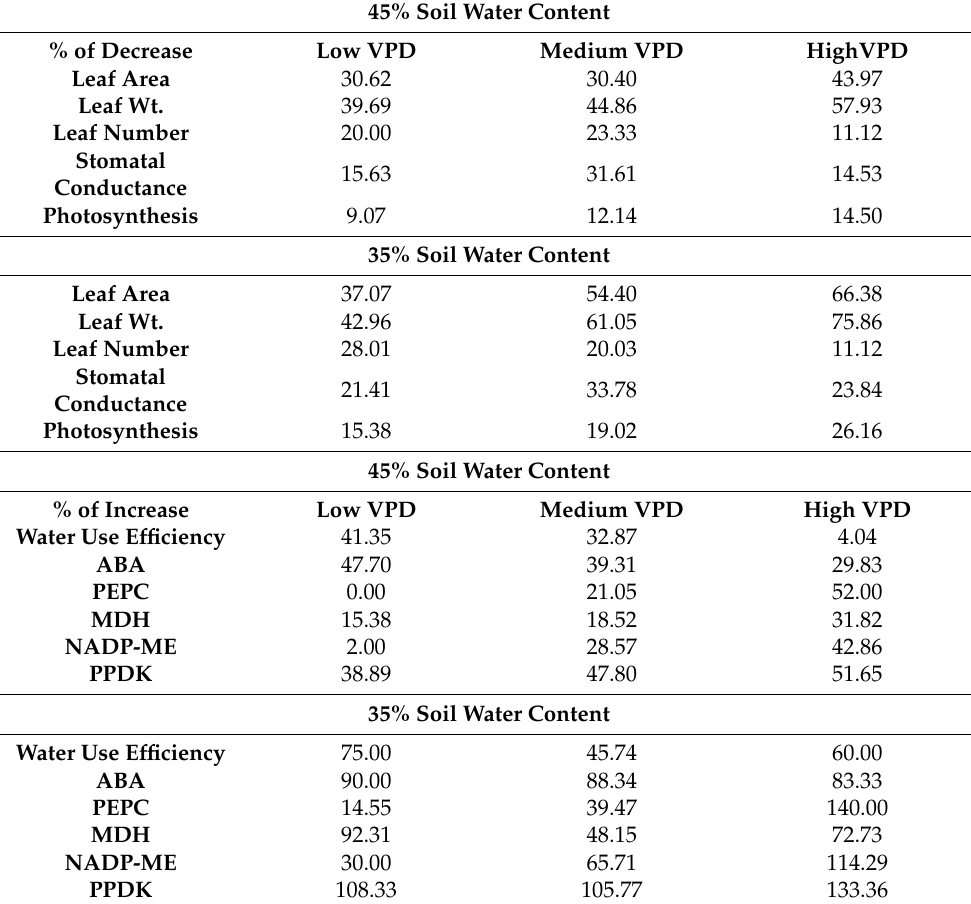
Table 1. Percentage of decrease and increase in different parameters measured under low, medium, and high VPD conditions at 45% and 35% Soil water content. The percentage of decrease or increase was calculated as a difference from well-watered conditions at that particular